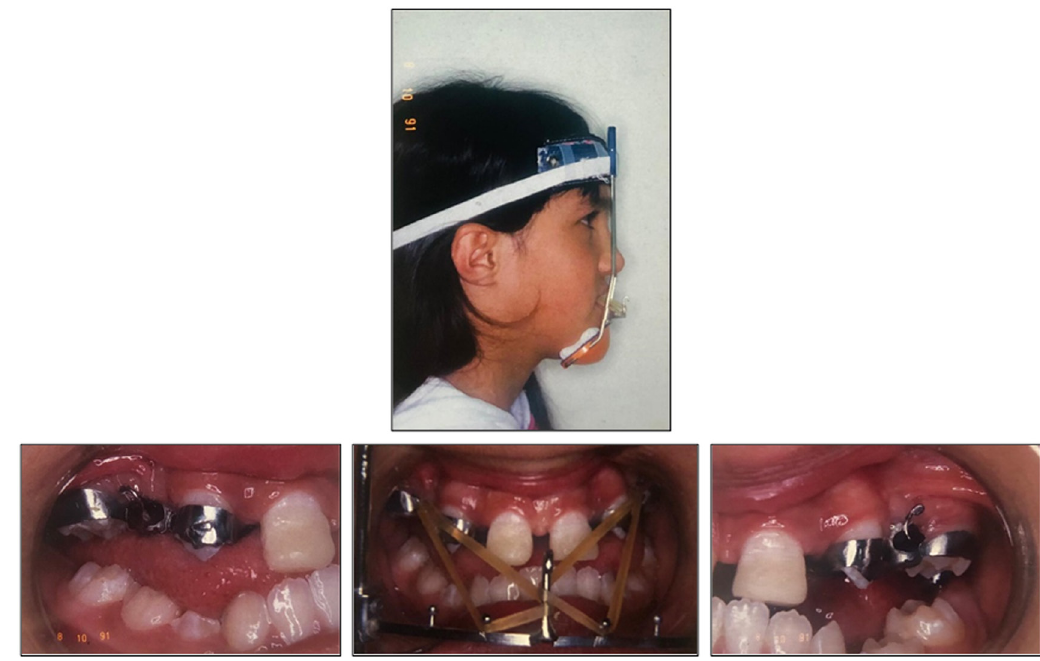
Figure 4. Tubinger facemask with photos demonstrating intraoral anchors.